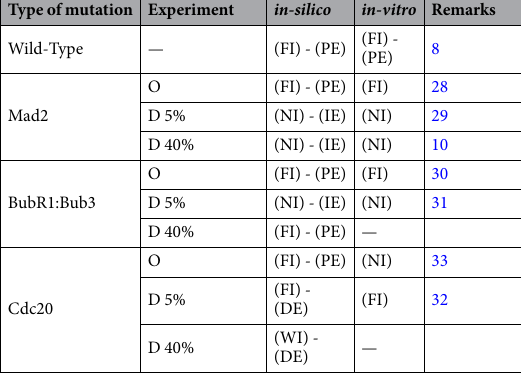
Table 1. Comparison of the in - vitro and in - silico mutation